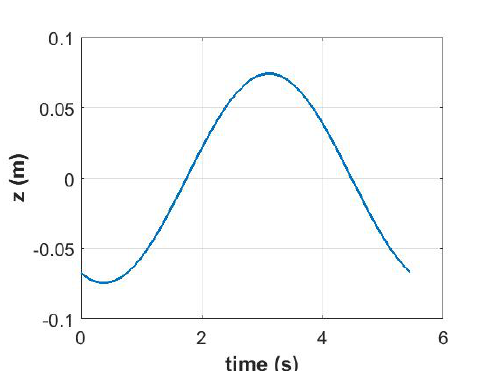
Figure 5. The control force for Case Study 1